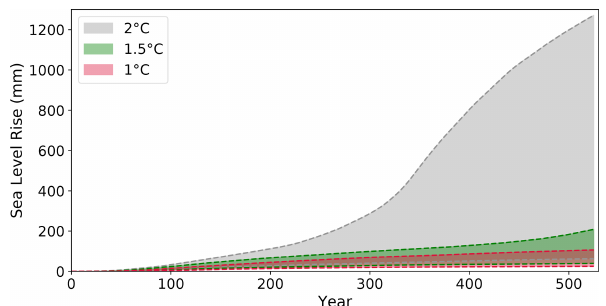
Figure 13. Range of sea level rise for all ensemble members, shaded color indicates the synthetic thermal forcing